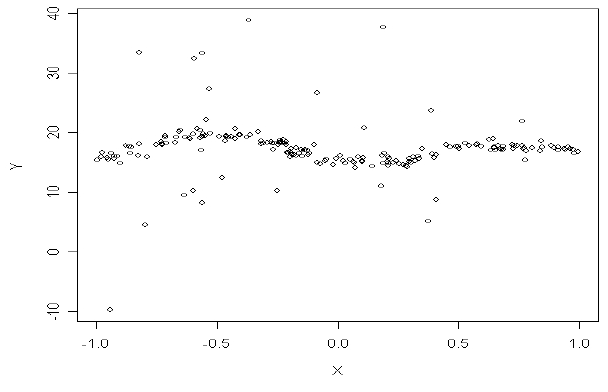
Figure 7 – Sample of 200 units generated from the model used in the first simulation experiment, with δ = 0.15 and τ =